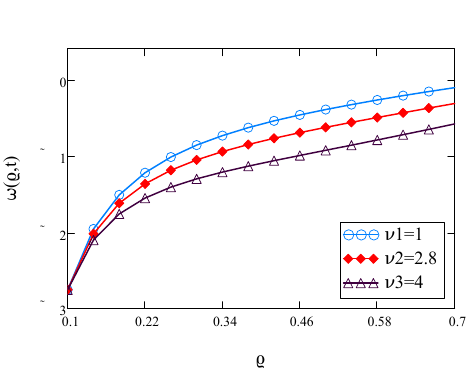
Figure 5. The influence of velocity w ( (cid:36) , t ) for R i = 0.1, R o = 0.7, β = 0.85, t = 1.90, (cid:105) = 3, A = 5 and Ω = 3 with various values of ν